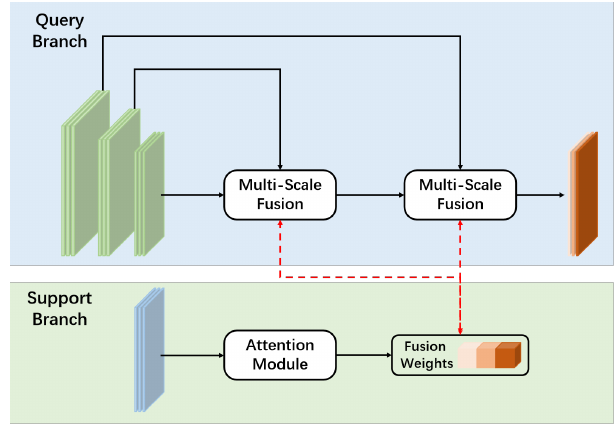
Figure 5. Multi-Scale